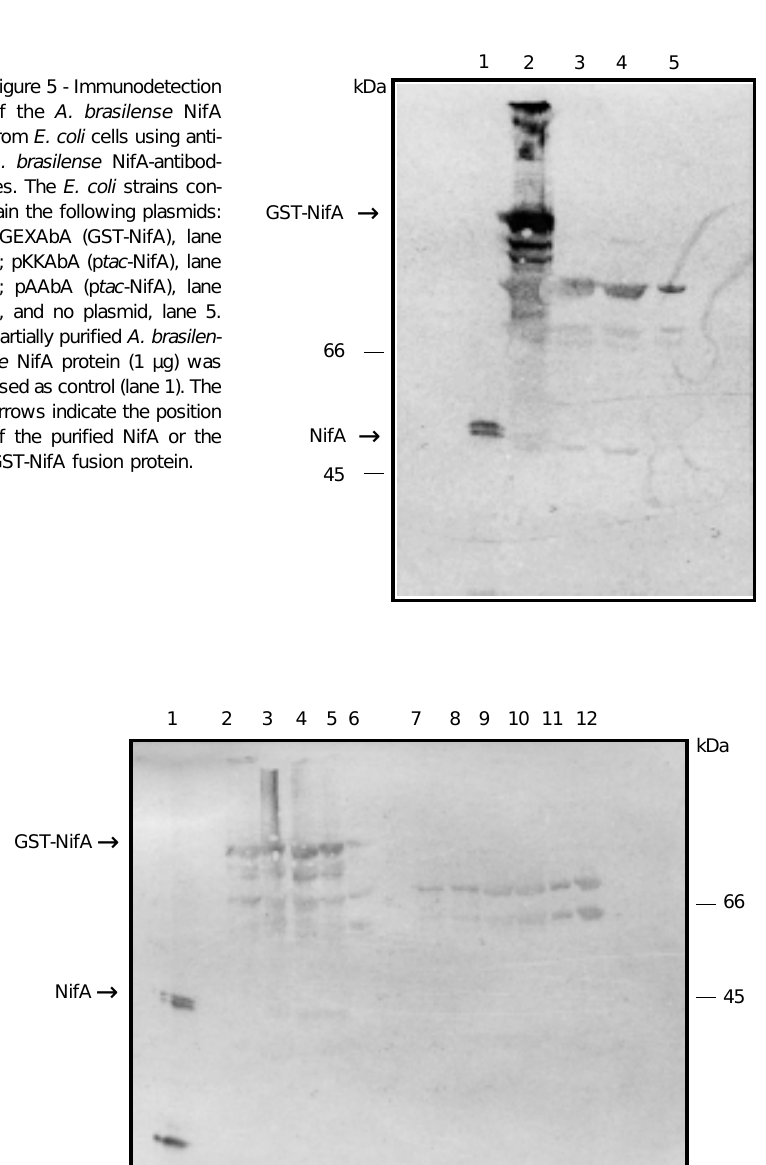
Figure 5 - Immunodetection